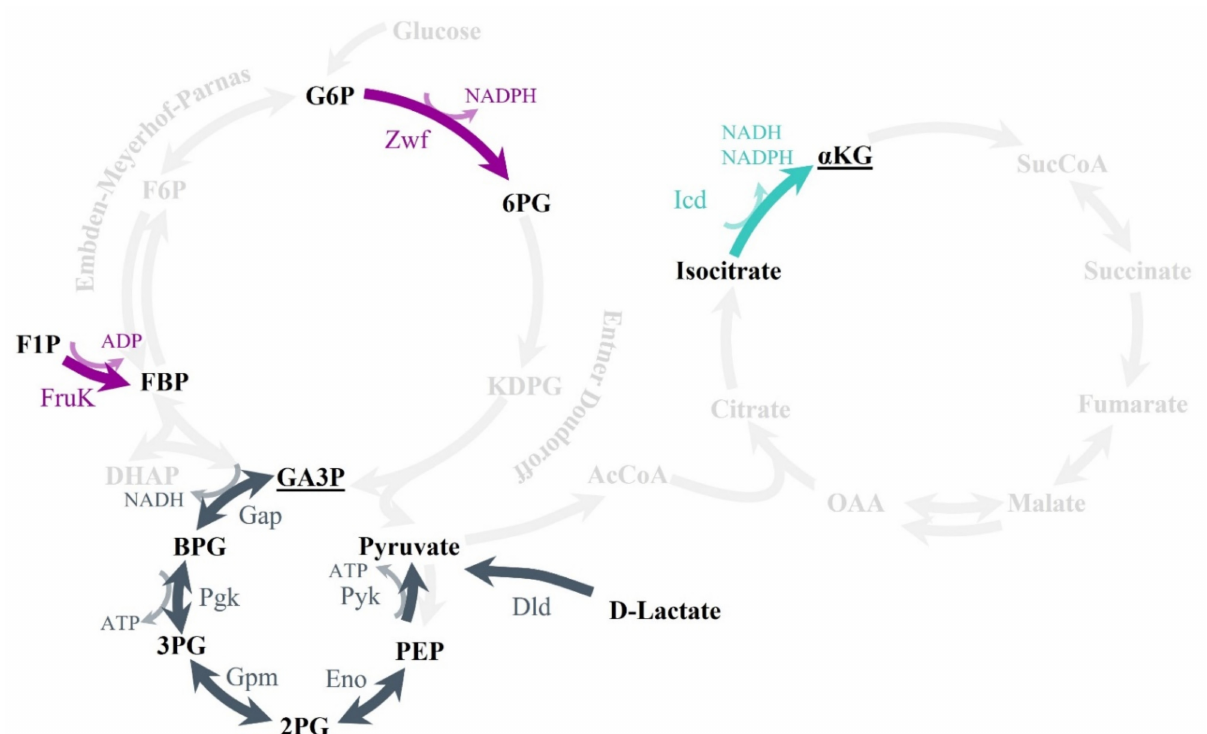
Figure 8. Effects of fosfomycin, PEP, and GA-3P on S. maltophilia ’s central metabolism. The en- zymes whose expression or activity was seen to be modified in the transcriptomics or in the activity measurements are indicated (see text for more details). Substrate abbreviations—G6P: